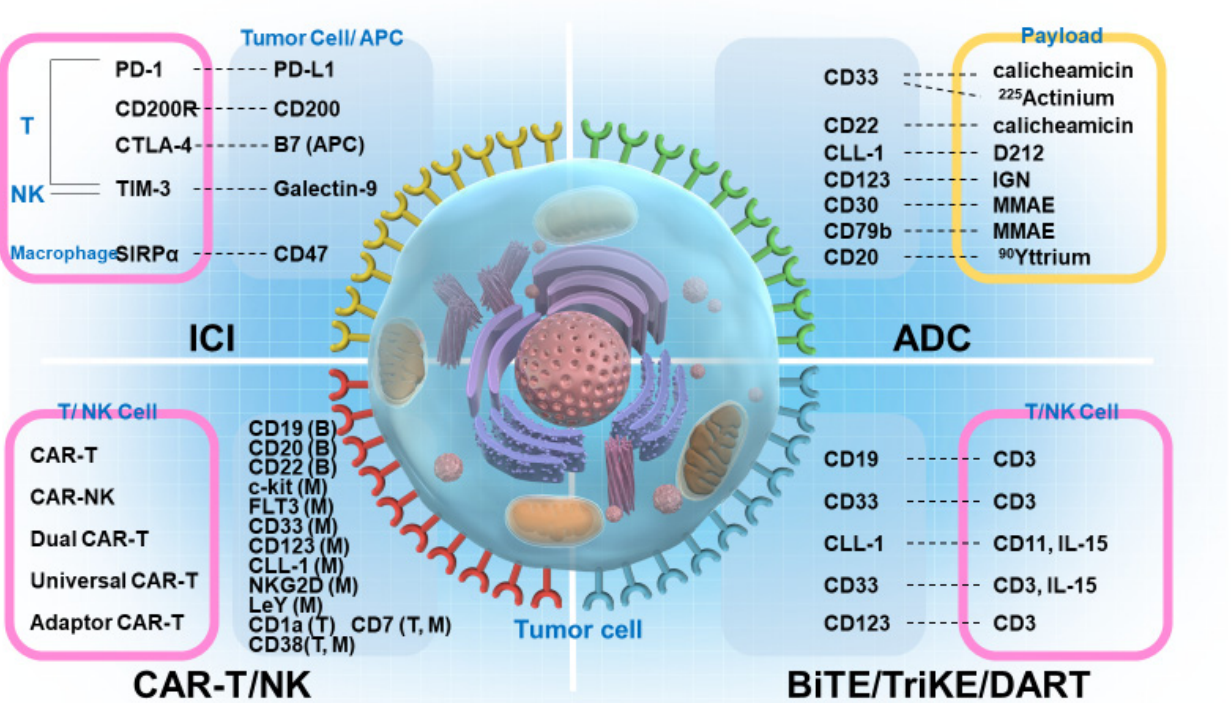
Figure 2. Potential target antigens involved in immune therapy against hematological malignancies. For immune checkpoint inhibitors (ICIs), the targets include programmed cell-death protein 1 (PD-1)/programmed death-ligand 1 (PD-L1), CD200R/CD200, T-cell immunoglobulin and mucin domain-3 (TIM-3)/galectin-9, SIRP α /CD47, and cytotoxic T-lymphocyte-associated protein 4 (CTLA-4)/B7 (APC). For antibody–drug conjugates (ADCs), the targets include CD33/calicheamicin, CD33/ 225 actinium, C-lectin-like molecule 1 (CLL-1)/D212, CD123/indolinobenzodiazepine pseudodimer (IGN), CD30/monomethyl auristatin E (MMAE), CD79b/MMAE, and CD20/ 90 yttrium. For chimeric antigen receptor (CAR)-transgenic T and CAR-natural killer (NK) cells, the targets include CD19, CD20, and CD22 B cells (B); c-kit, FLT3, CD33, CD123, CLL-1, NKG2D, and LeY myeloid (M) cells; CD1a T cells (T); and CD7 and CD38 T and M cells. For bispecific T-cell engager (BiTE), trispecific killer cell engager (TriKE), and dual affinity retargeting (DART) therapies, the targets include CD19/CD3, CD33/CD3, CLL-1/CD11 and IL-15, CD33/CD2 and IL-15, and CD123/CD3.